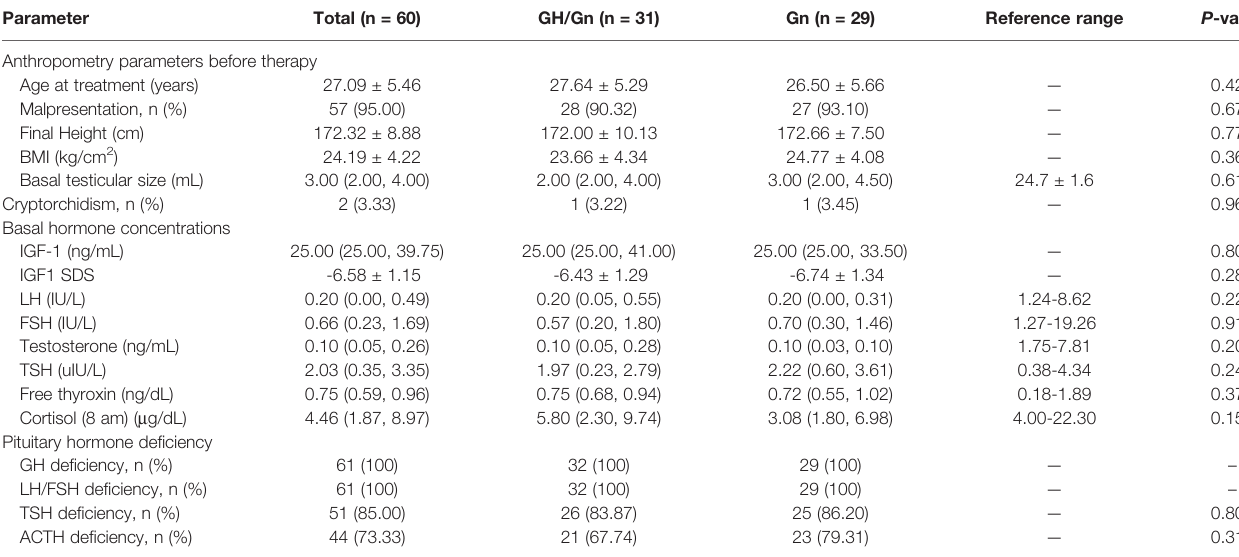
TABLE 1 | The baseline features of male patients with